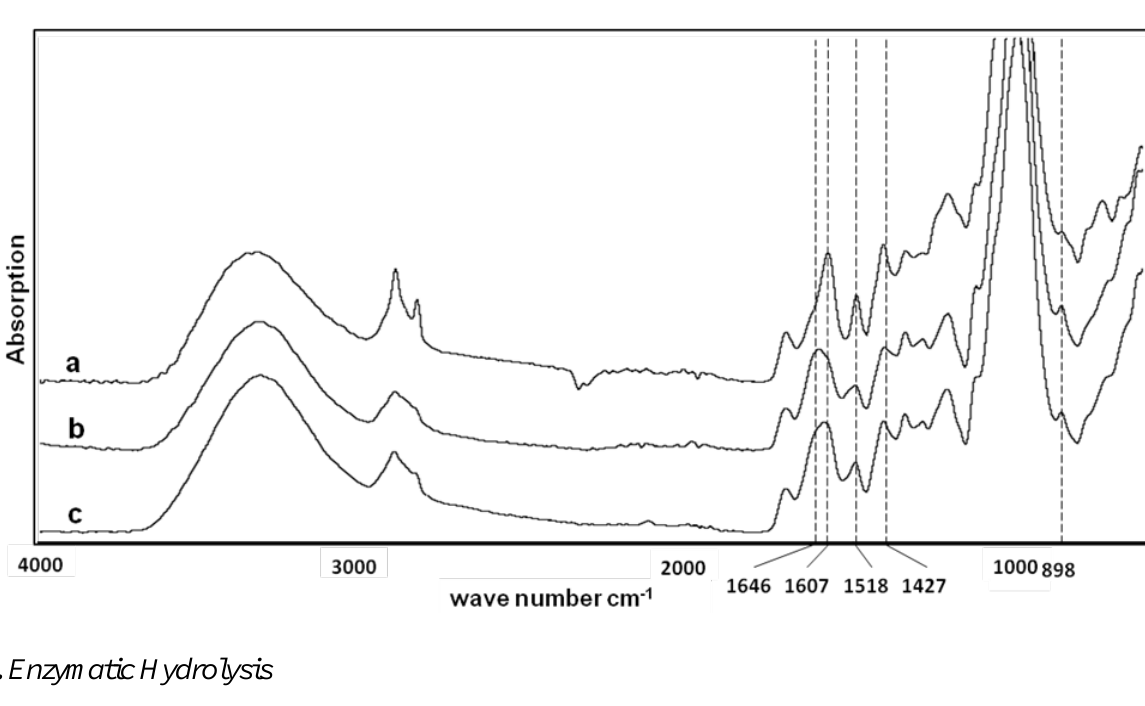
Figure 1. FTIR spectra of high lignin fiber ( a ) and low lignin fiber ( b ) and the date palm fiber ( c